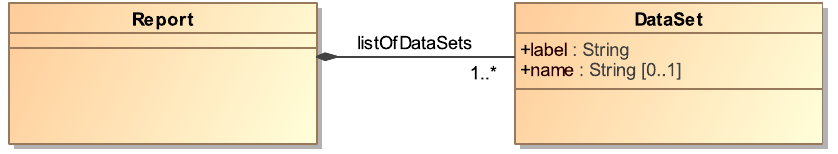
Figure 2.42: The SED-ML Report class